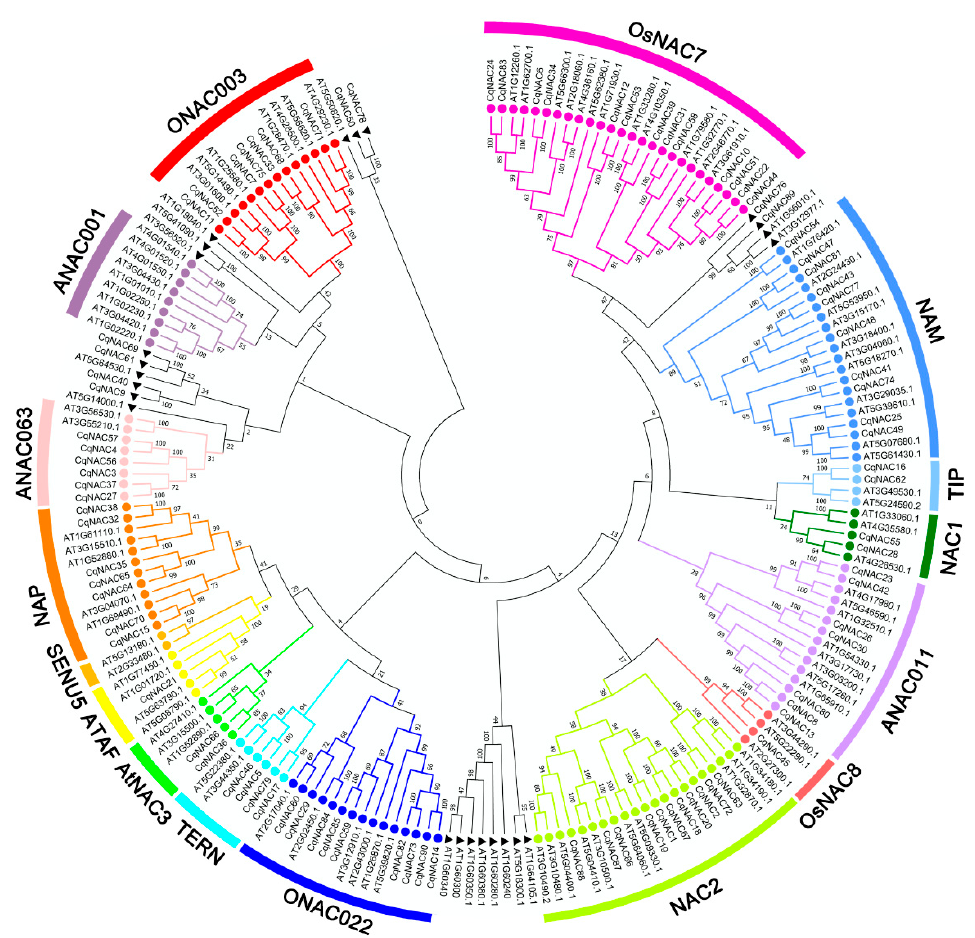
Figure 1. Phylogenetic relationships of the NAC family in quinoa and Arabidopsis . Full-length amino acid sequences were aligned using ClustalW, and the phylogenetic tree was constructed using the MEGA7 method. The subfamilies are labeled and indicated with different colors. The NACs labeled with a black triangle indicate no group members. The numbers at the nodes represent bootstrap support values from 1000 replicates.